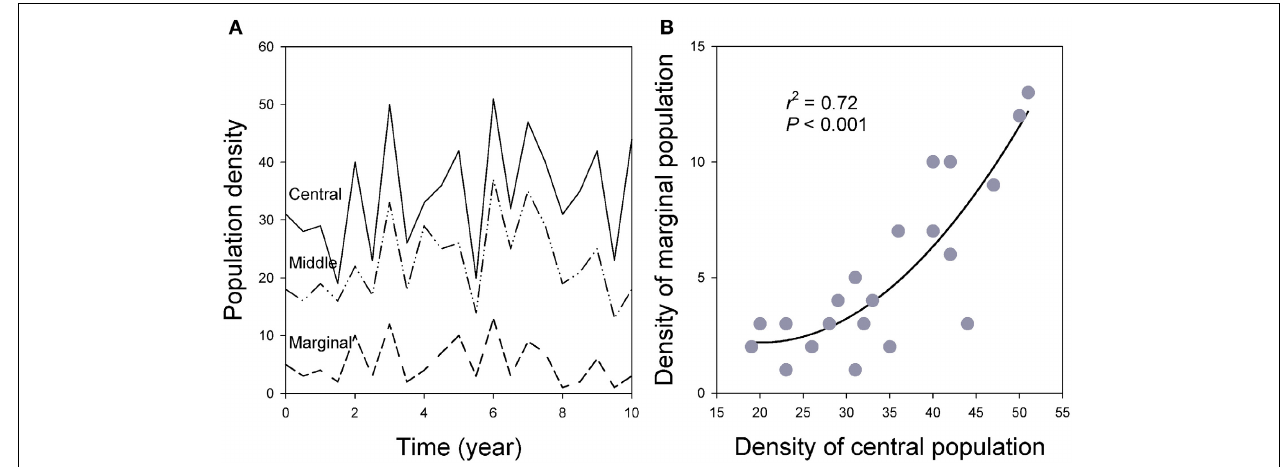
FIGURE 9 | (A) Population synchronization across the species’ ranges in which marginal populations show greater variation measured by CV of population density over time. (B) Population densities are closely related